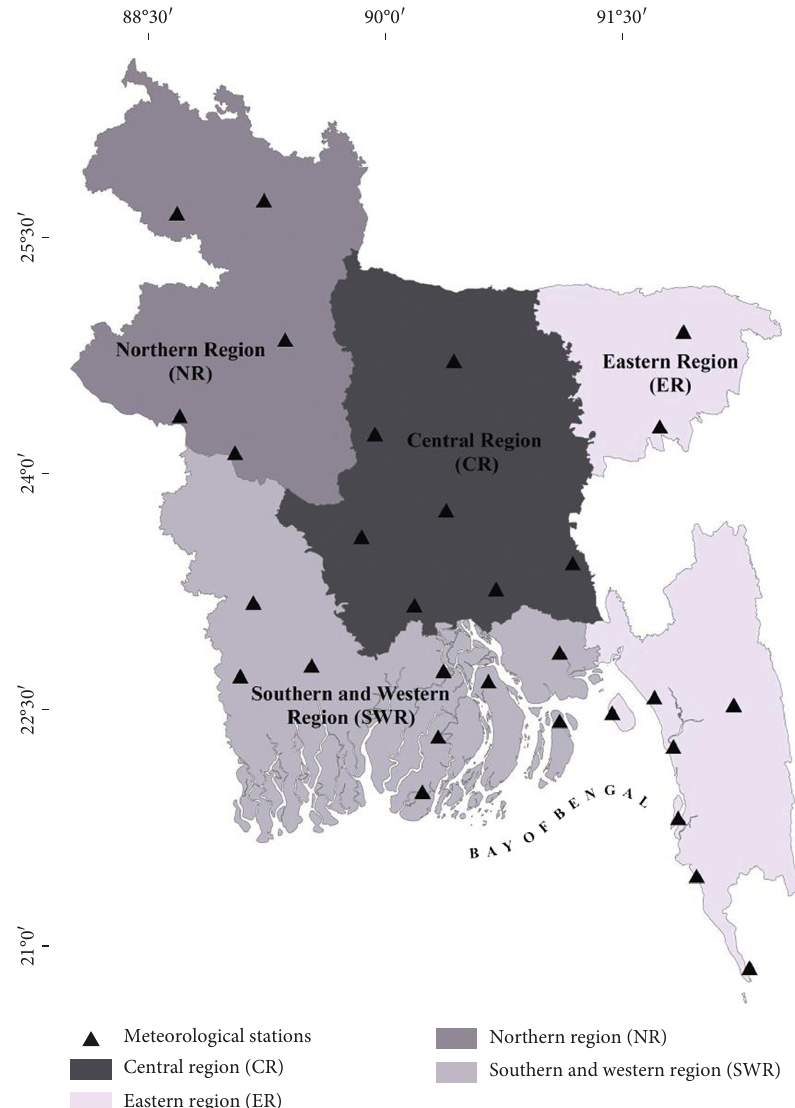
Figure 1: Map of the study